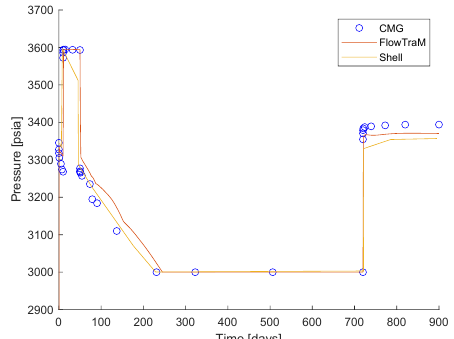
Figure 12. Comparison of Borehole pressure at production well.